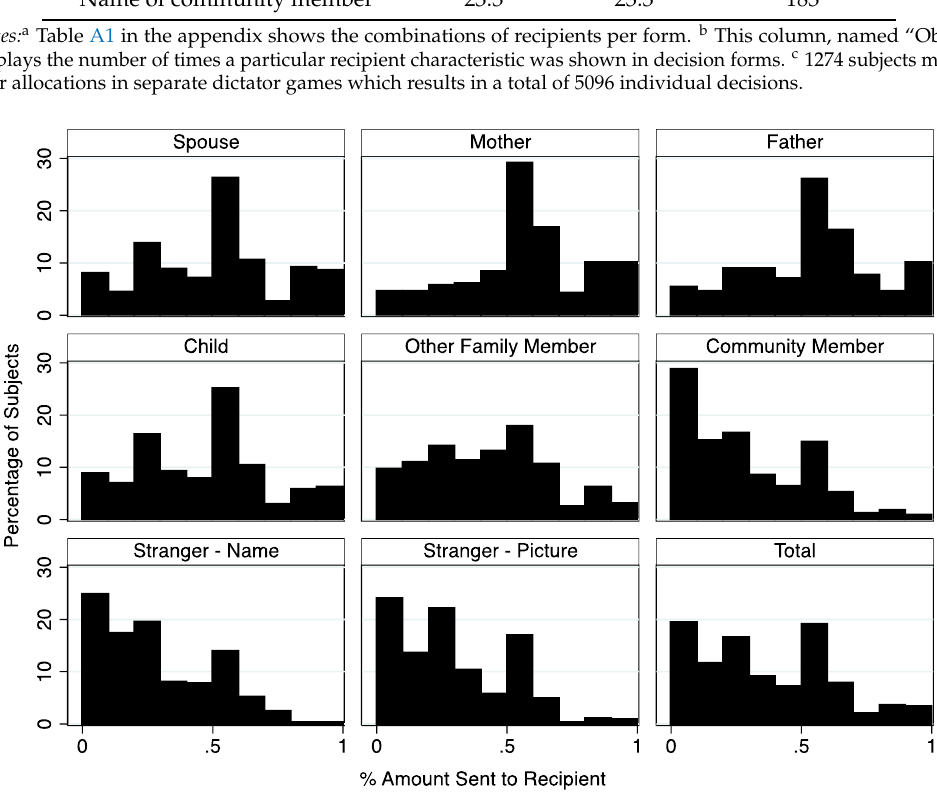
Figure 1. Distribution of giving by recipient characteristic. Note: Each panel displays the distribution of giving per recipient characteristic.